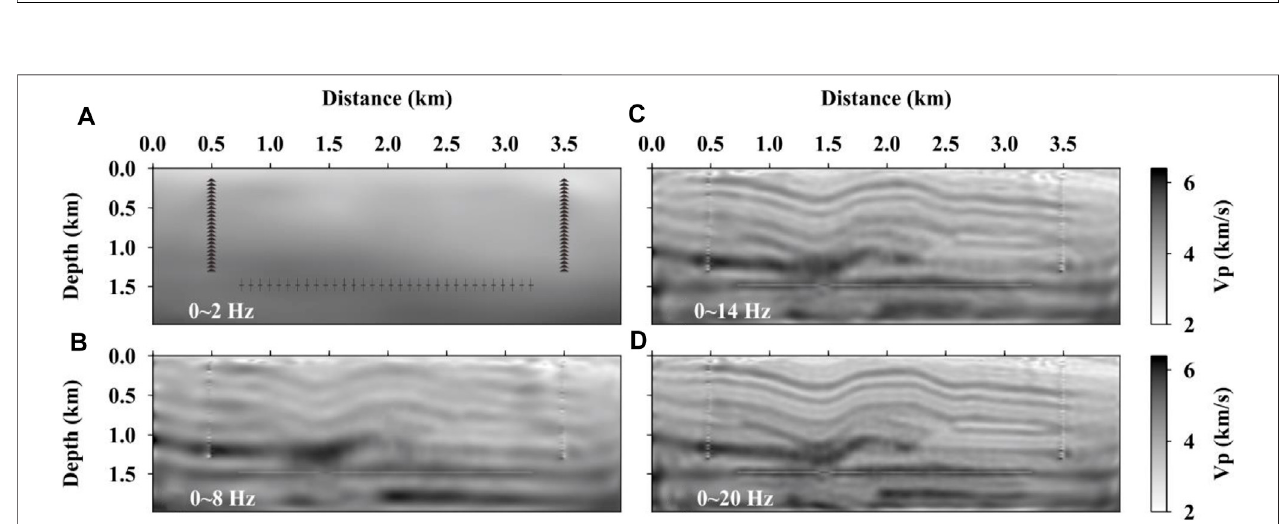
FIGURE 6 | Inversion results of the PO data. The black triangles on the left and the black cross symbols at the depth level of 1.5 km shown in (A) represent the receivers in the observation well and the perforations in the horizontal well, respectively. (A – D) Iterative inversion results of the frequency groups of 0 – 2, 0 – 8, 0 – 14, and 0 – 20 Hz, respectively.